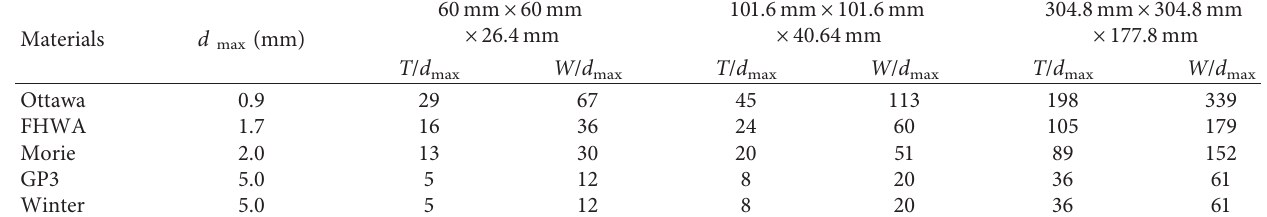
Table 3: Materials and specimen sizes used in direct shear tests by Cerato and Lutenegger [123]. Materials